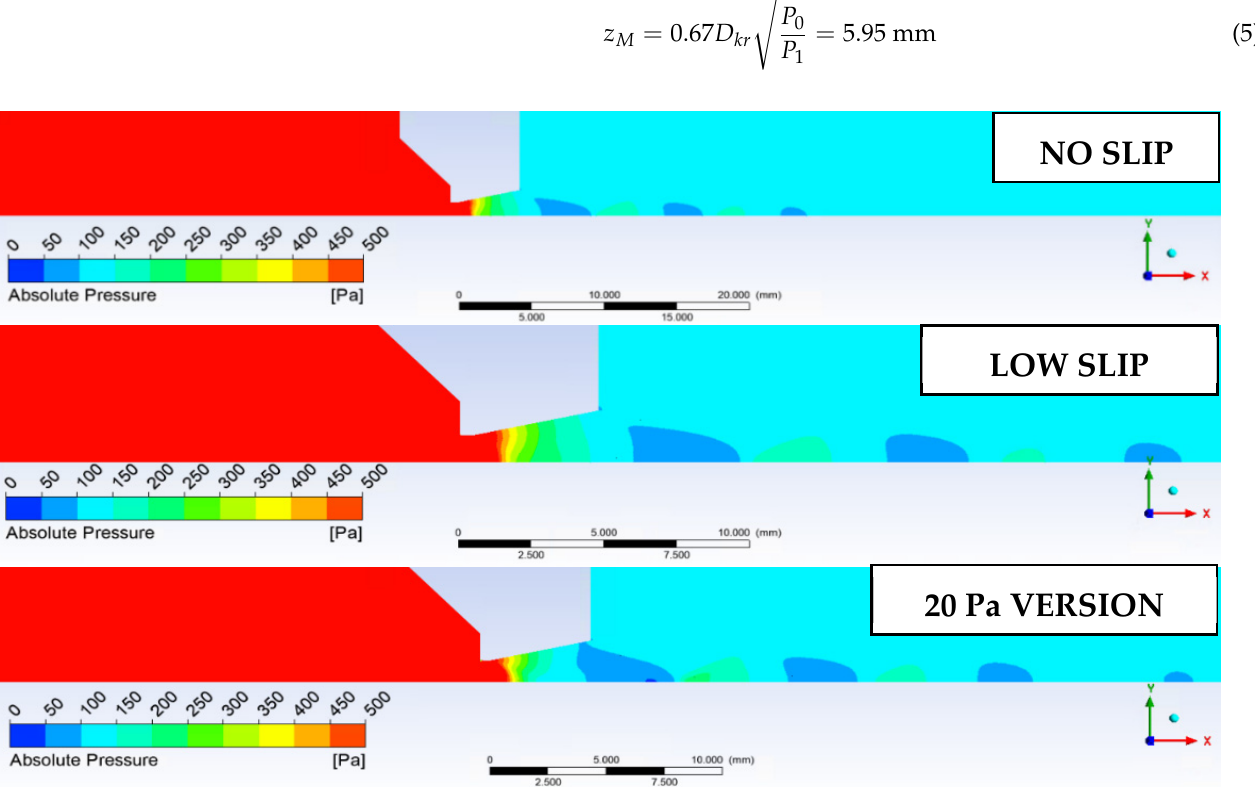
Figure 20. Distribution of Mach disks for the investigated variants.